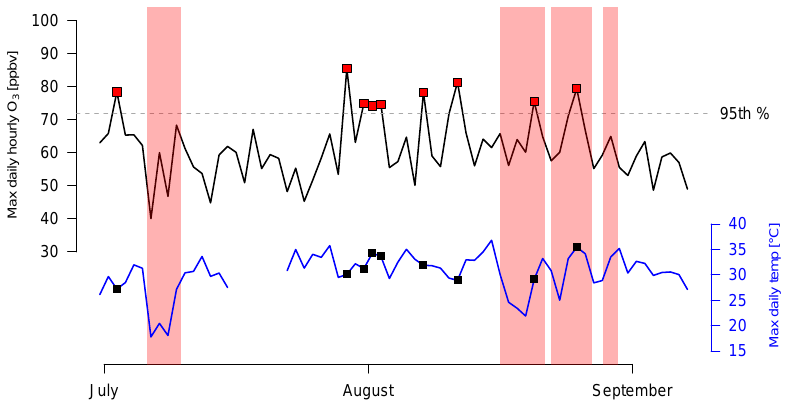
Figure 7. Maximum hourly average O 3 mixing ratios for each day at BAO plotted in black with maximum daily temperature at BAO in blue. Red boxes denote days that exceed the 95th percentile of all hourly average O 3 mixing ratios between 11:00 and 16:00MDT. Black boxes pinpoint these same days in the temperature time